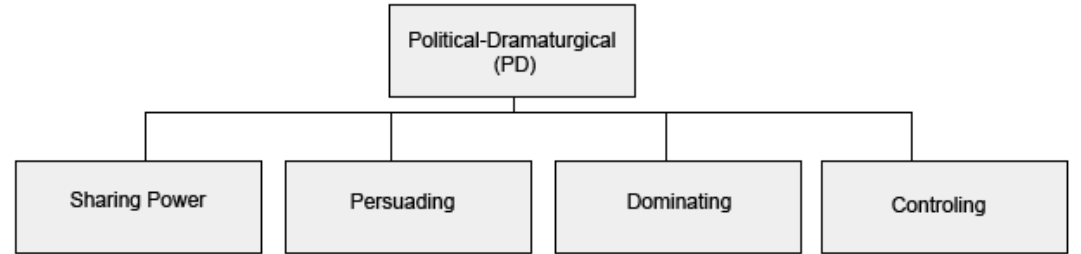
Figure 3 . Political-dramaturgical